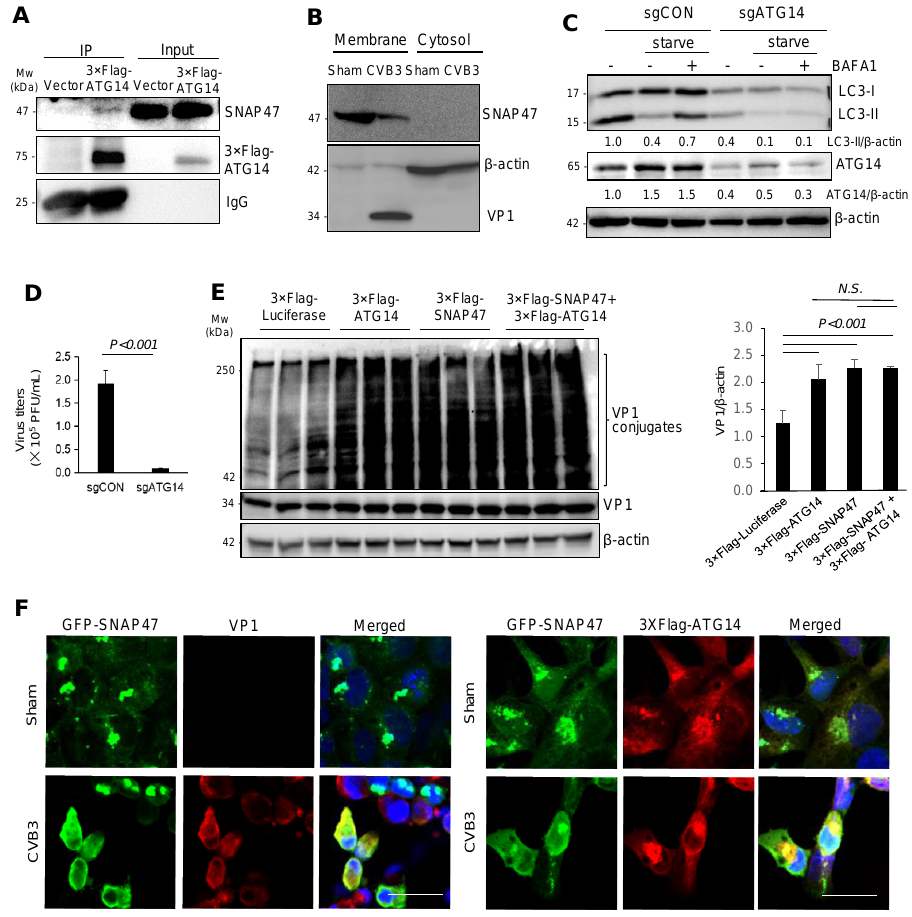
Figure 4. SNAP47 interacts with ATG14 to promote viral capsid assembly on cellular membrane. ( A ) Co-immunoprecipitation was performed on the HeLa cell lysates overexpressing 3 × Flag-ATG14 using anti-Flag antibody. SNAP47 and 3 × Flag-ATG14 were blotted to assess the protein interaction. IgG light-chain was used as a loading control. ( B ) Cell fractionation was performed on the cell lysates harvested from HeLa cells infected with CVB3 or sham-infected (MOI = 10, 7 h) to separate the membrane and cytosol fraction. Western blot was conducted to detect SNAP47, VP1, and β-actin. ( C ) HeLa cells transfected with sgCON (control) or sgATG14 were starved in HBSS medium with or without BAFA1 (200 nM) for 6 h. Western blot was conducted for examination of ATG14, LC3, and β-actin. LC3-II/β-actin and ATG14/β-actin were quantified by densitometry analysis and are shown below the blot. ( D ) HeLa cells depleted of ATG14 with sgRNA were infected with CVB3 (MOI = 0.1) for 24 h. TCID50 was conducted to measure viral titer (mean SEM, n = 3). ( E ) HeLa cells transfected with 3 × Flag-Luciferase, 3 × Flag-ATG14, 3 × Flag-SNAP47, or 3 × Flag-SNAP47 plus 3 × Flag-ATG14 were infected with CVB3 (MOI = 10) for 7 h. The cell lysates were collected and blotted for VP1and β-actin. T-test was performed on the relative densitometry of VP1 conjugation (mean SEM, n = 3). ( F ) HEK293T cells transfected with GFP-SNAP47 and 3 × Flag-ATG14 were infected with CVB3 (MOI = 10) for 7 h. Immunocytochemical staining was conducted using anti-Flag and anti-VP1 antibodies. Scale bar = 25 µm.